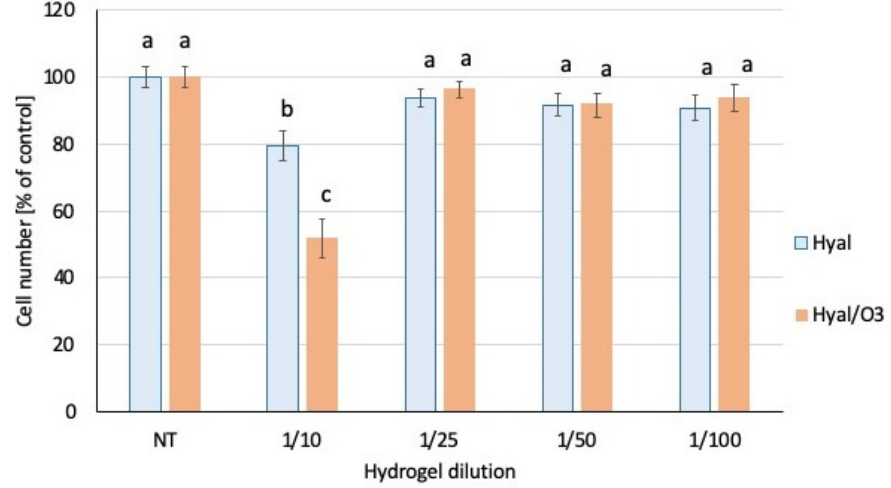
Figure 7. Number of viable cells in the culture. The bars represent the mean number of cells ( n = 8) ± SD. Values denoted with the same letters do not differ statistically at the level of confidence p < 0.05.